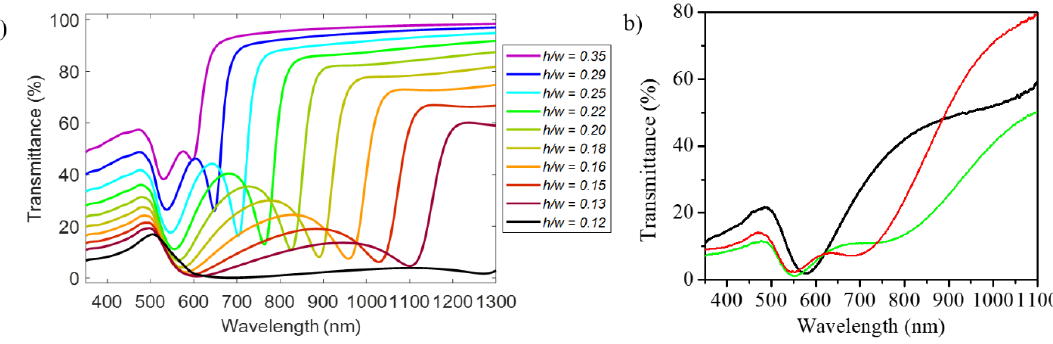
Figure 4. ( a ) FEM calculations of nanostripe dimers’ optical behavior as a function of the Au nanostripes aspect ratio h / w, which is varied by acting on w and keeping h fixed to 22 nm. The silica spacer is set to 24 nm thickness and the array periodicity is 210 nm; and ( b ) TM-polarized optical extinction spectra of nanostripe dimer arrays, where the Au-SiO 2 -Au layers thickness was tailored as follows: 30-44-30 nm (red curve), 22-44-22 nm (green curve) and 22-22-22 nm (black curve).